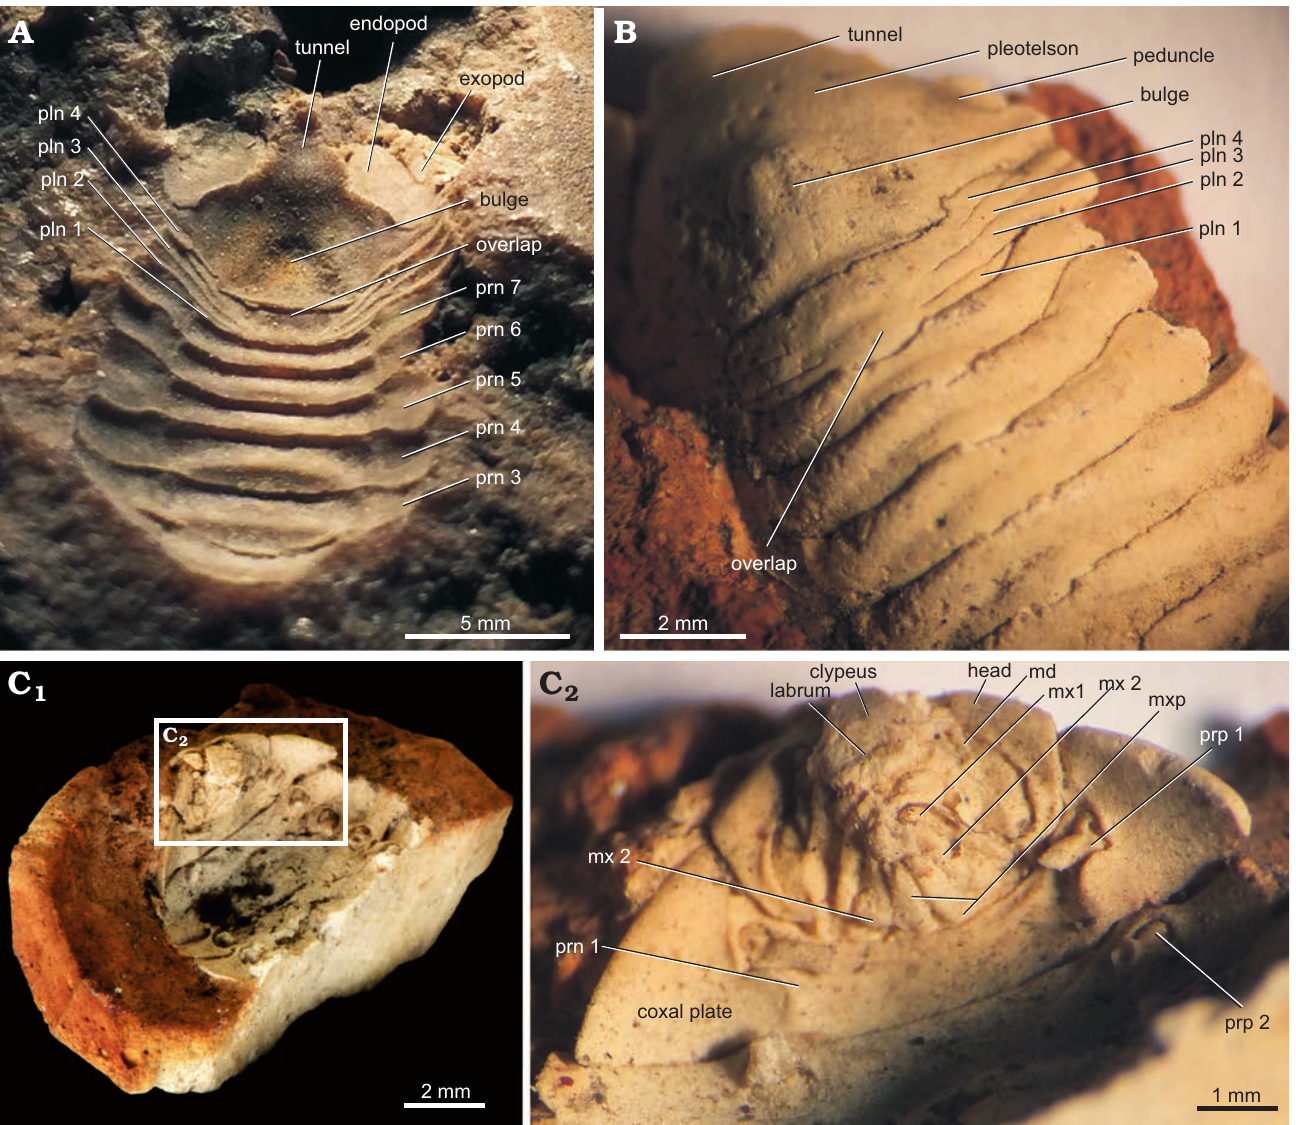
Fig. 2. Detailed anatomy of isopod Heterosphaeroma priscum (Milne-Edwards, 1868), late Thanetian of Sézanne, Marne, France. A . SU.PAL.2017.0.2.61 (inner mold, holotype), in dorsal view. B . SU.PAL.2017.0.0.4 (plaster cast), in dorsal view. C . SU.PAL.2017.0.2.4 (C close-up), ventral side. Abbreviations: md, mandibular palp; mxp, maxilliped; mx, maxilla; pln, pleonite; prn, pereonite; prp, pereopod. Photographs RV and Rémi Brageu